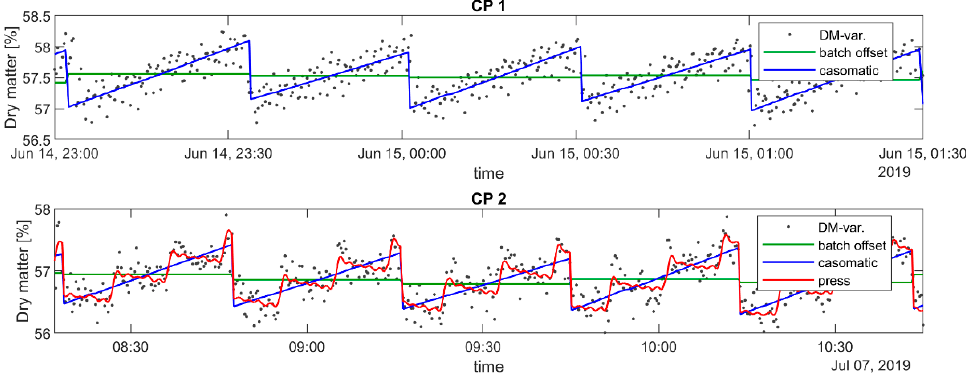
Figure 8. Zoom on a short period of the decomposition of dry matter measurements at CP1 and CP2—both from 2019. These decompositions are displayed as successive accumulations: x µ + x b , x µ + x b + x c etc. The CP1 period does not include the press signal, and neither include the “column” ( 𝑥 (cid:3083) [𝑛] ) signal.